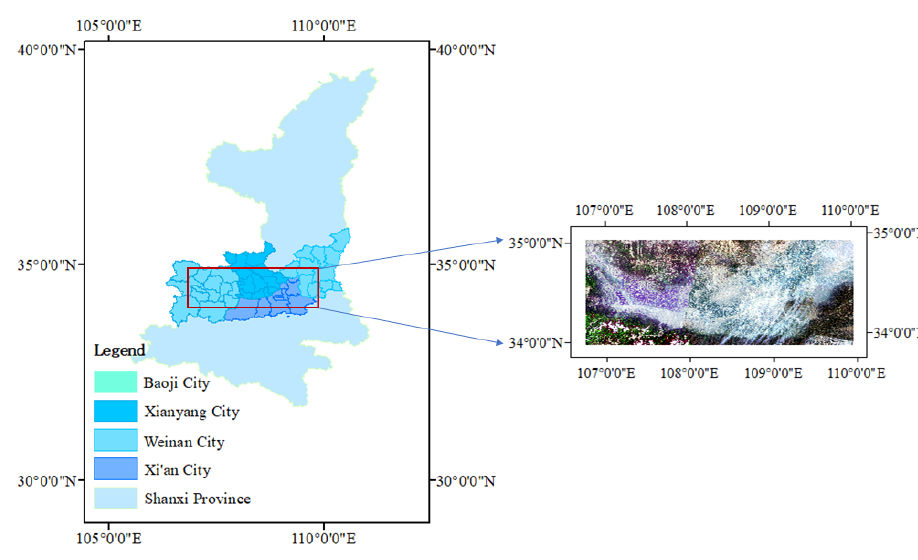
Figure 1. Geographical location of the study